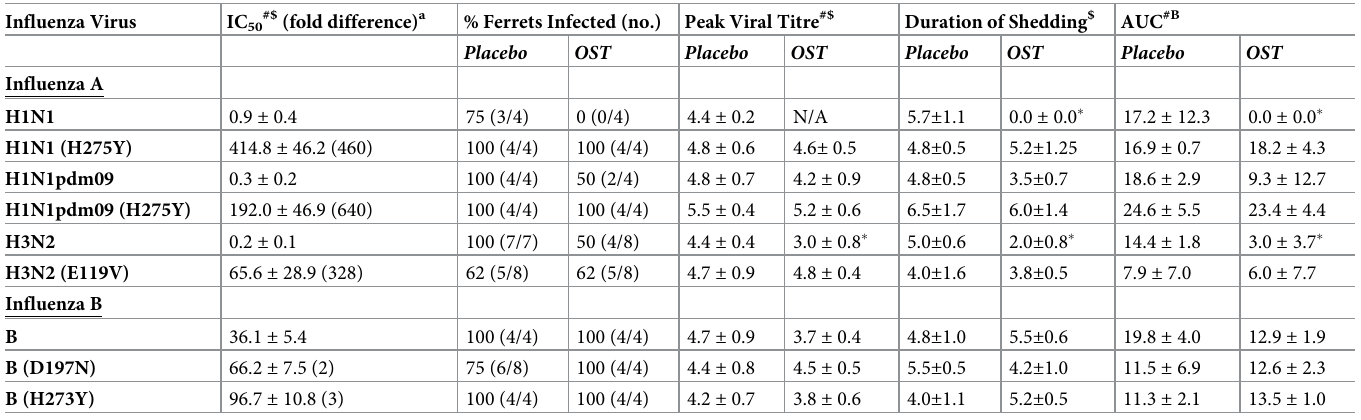
Table 1. The IC 50 values of infecting viruses and viral shedding characteristics of ferrets dosed with either placebo or oseltamivir. Influenza